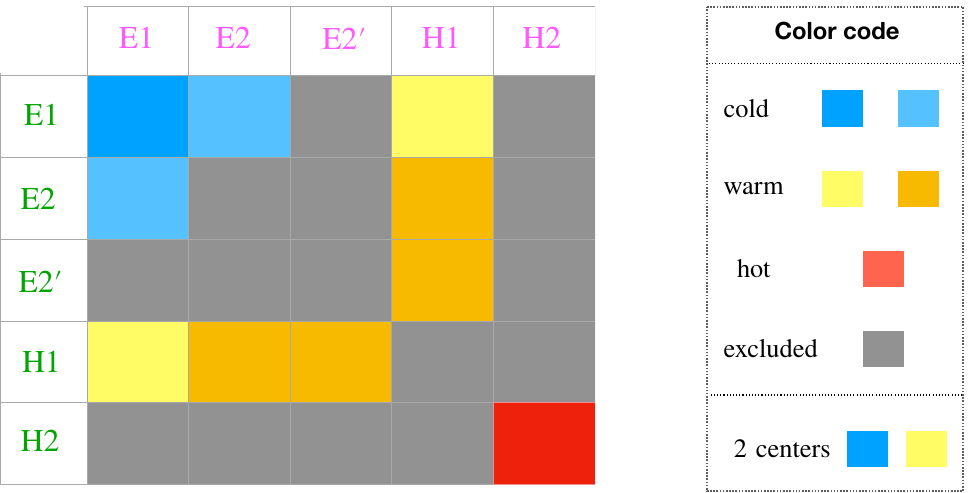
Figure 6 . Phases of the domain-wall spacetime. The type of the green slice labels the rows of the table, and that of the pink slice the columns. In the hot (red) phase the wall enters the black-hole horizon, while in the warm (yellow) phases it avoids it. The cold (blue) phases have no black hole. Geometries in which an inertial observer is attracted to two different centers are indicated by a different shade (light yellow or darker